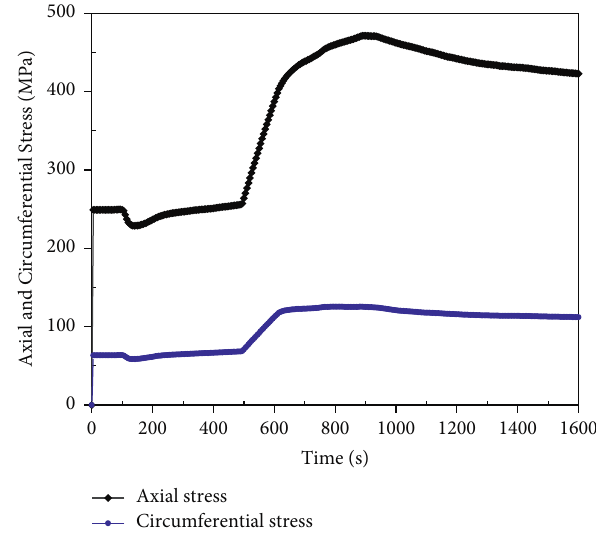
Figure 12: Axial and circumferential stress variation at the maximal stress concentration area in the FE vessel model during the PTS